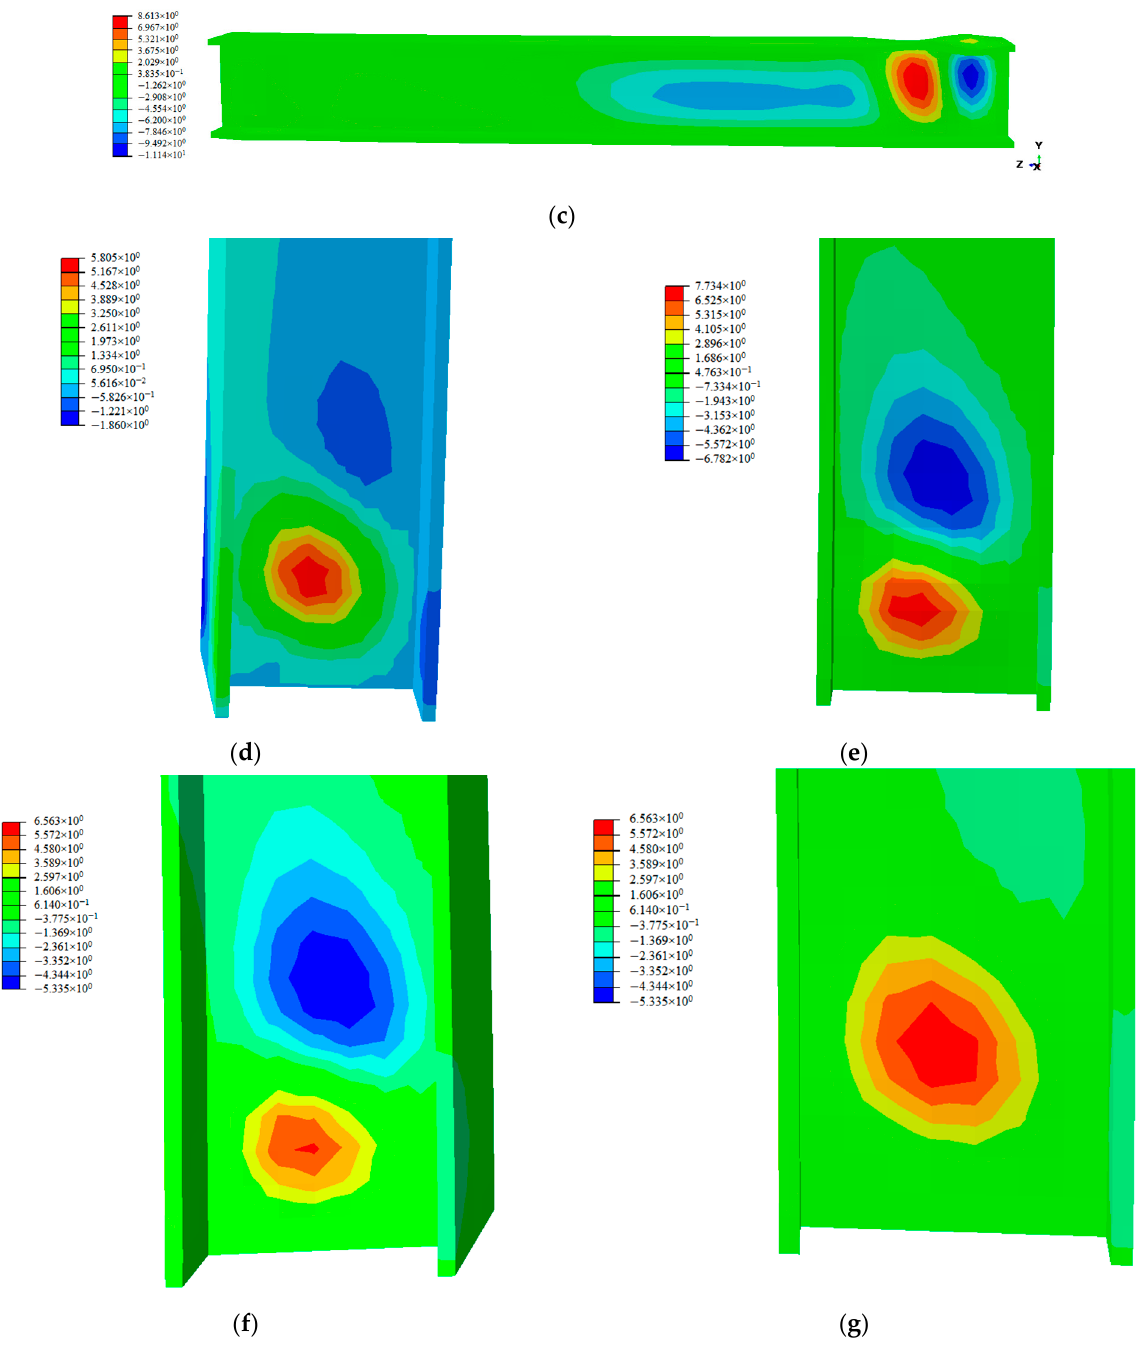
Figure 19. Local buckling at frame beams and columns of SPSWs with bolt connection at the drift ratio of 0.025: ( a ) frame beam web of SPSW-N8; ( b ) frame beam web of SPSW-N14; ( c ) frame beam web of SPSW-N20; ( d ) column web near column bottom of SPSW-N8; ( e ) column web near column bottom of SPSW-N14; ( f ) column web near left column bottom of SPSW-N20; ( g ) column web near right column bo tt om of SPSW-N20.